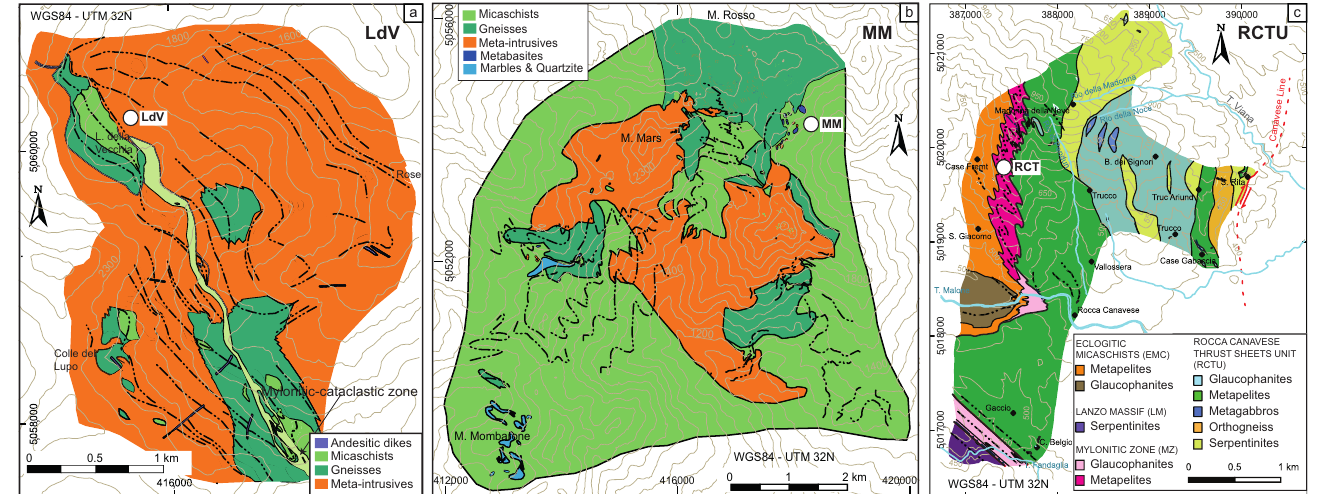
Figure 4. Geological maps of the ( a ) Lago della Vecchia (LdV) area modified after [30], ( b ) Monte Mucrone (MM) area modified after [9], and ( c ) Rocca Canavese Thrusts Unit (RCTU) area modified after [19,63]. White dots represent the locations of analysed samples. Black dashed lines represent the trajectory of the dominant Alpine